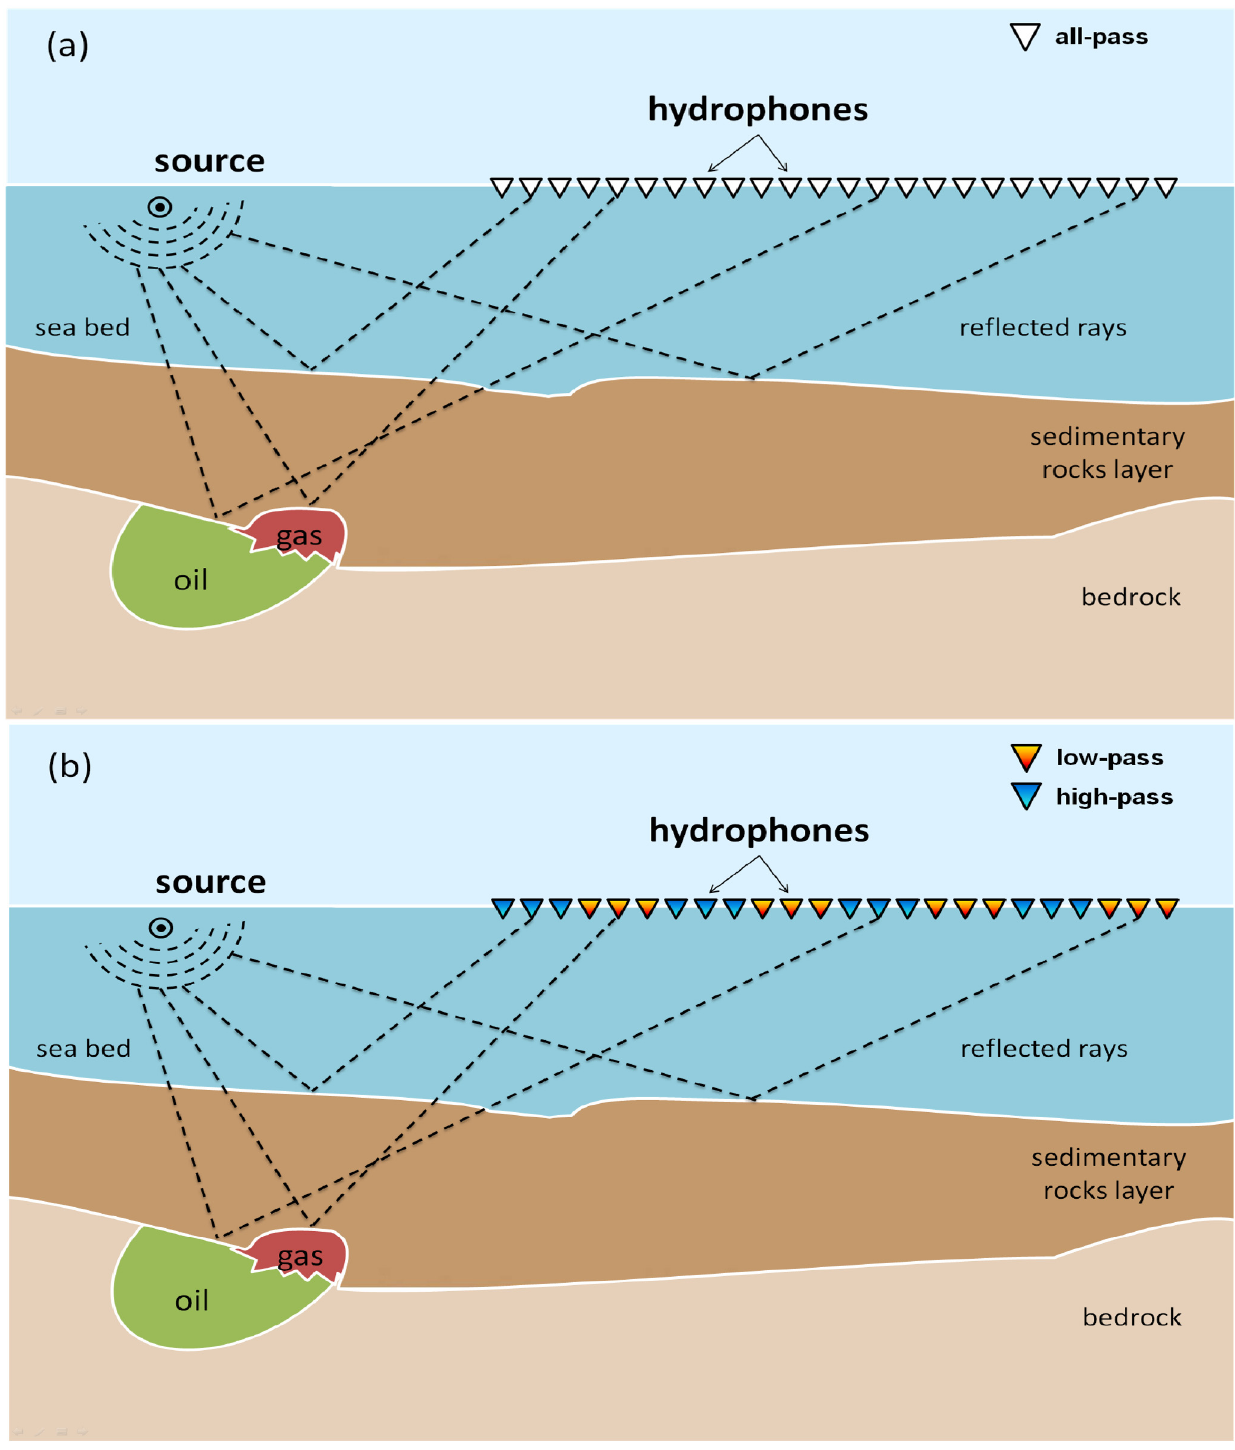
Fig 1. Sketch of a typical seismic exploration showing a source and an array of hydrophones. The propagated waves reflected in the geologic layers are indicated by rays that are reflected at the interface between different media. In (a), we present a conventional schema with identical sensors, while in (b), we show our acquisition design consisting of alternate sets of low-pass and high-pass sensors (represented by triangles of different colors).